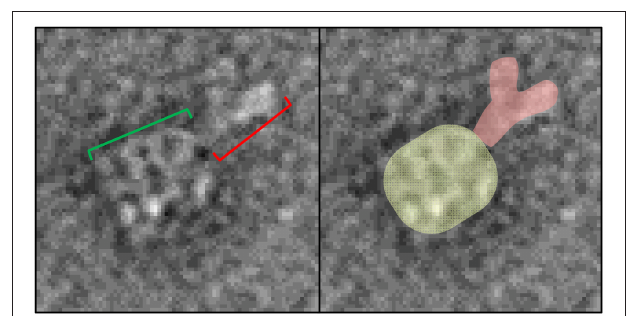
FIGURE 9 | GroEL-IgG complex EM image. (Left) Representative particle of the DTT released complex from the modified bGroEL biosensor. The four parallel dark bars are GroEL (green bracket). The dark, extra density to the top right of GroEL is the captured IgG (red bracket). (Right) Same image where the proteins are false colored to aid in visualizing the protein boundaries. Images obtained at